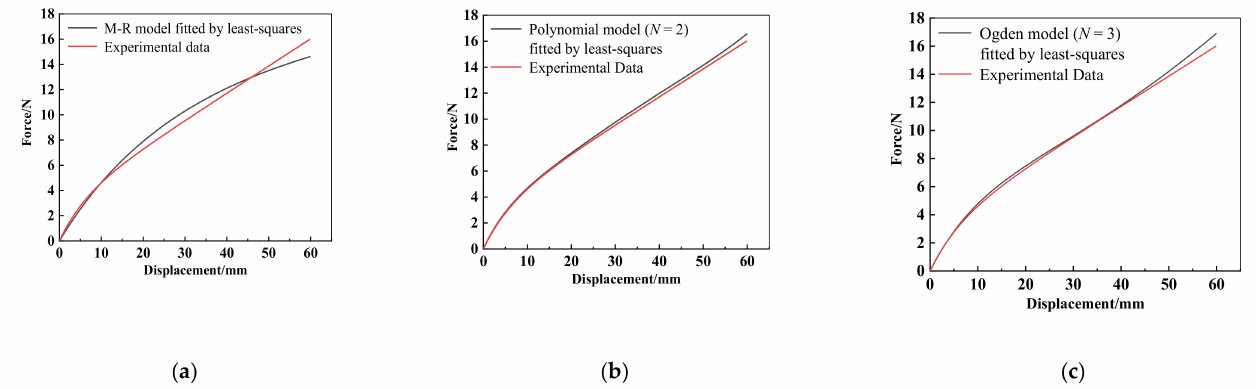
Figure 7. Results comparisons of: ( a ) M-R model; ( b ) polynomial model ( N = 2); and ( c ) Ogden model ( N = 3) fitted by least-squares with experimental data.